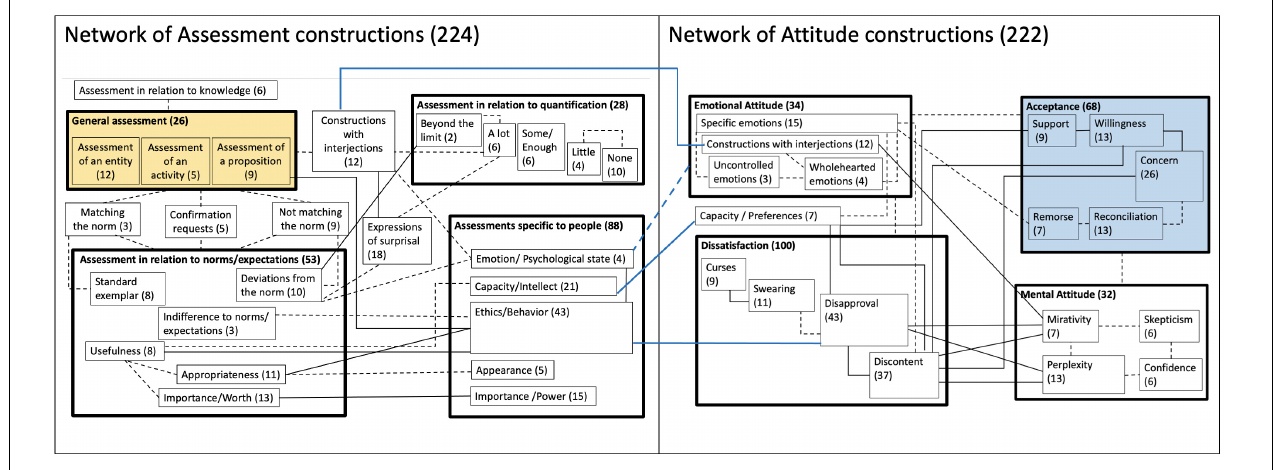
FIGURE 5 | Overlap of Assessment and Attitude